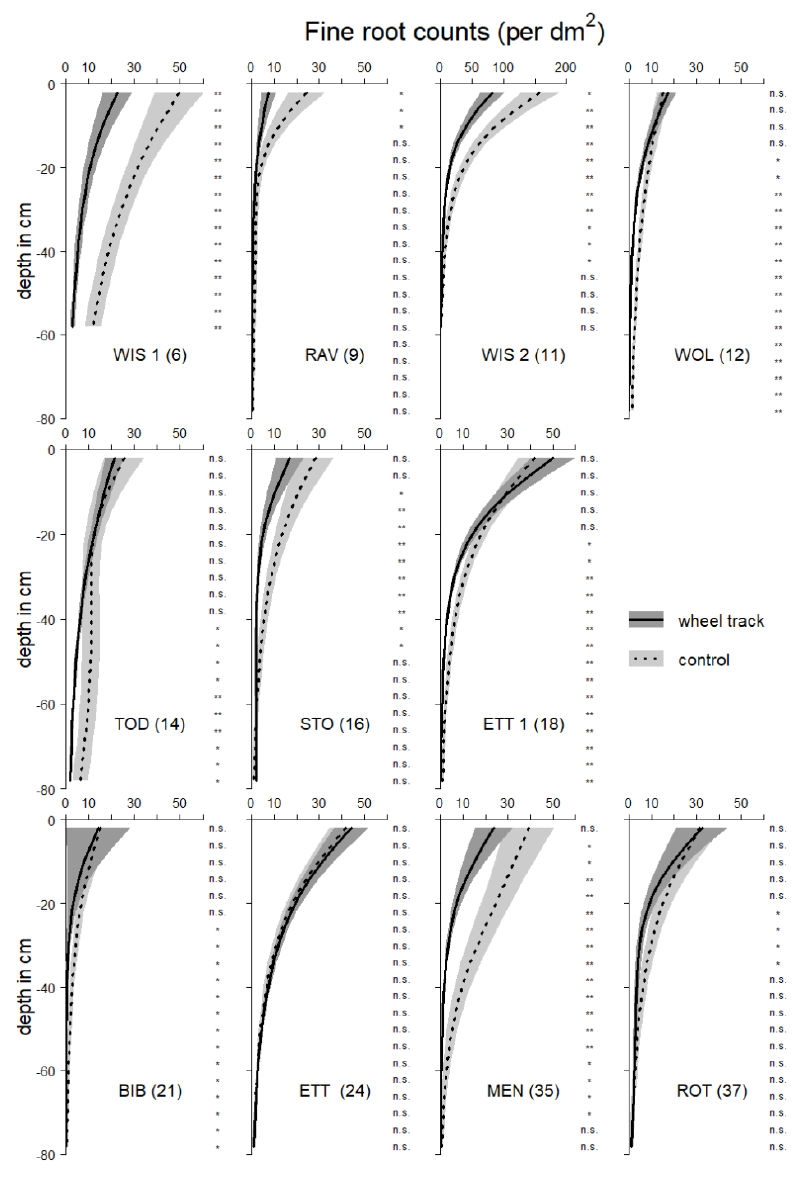
Figure 9. Depth gradients for the mean fine root densities of the wheel track and control strata. Confidence limits were derived based on the GAM predictions. Significance levels were assigned on the basis of three (** p < 0.01) and two standard deviations (* p < 0.05), n.s.= not significant).